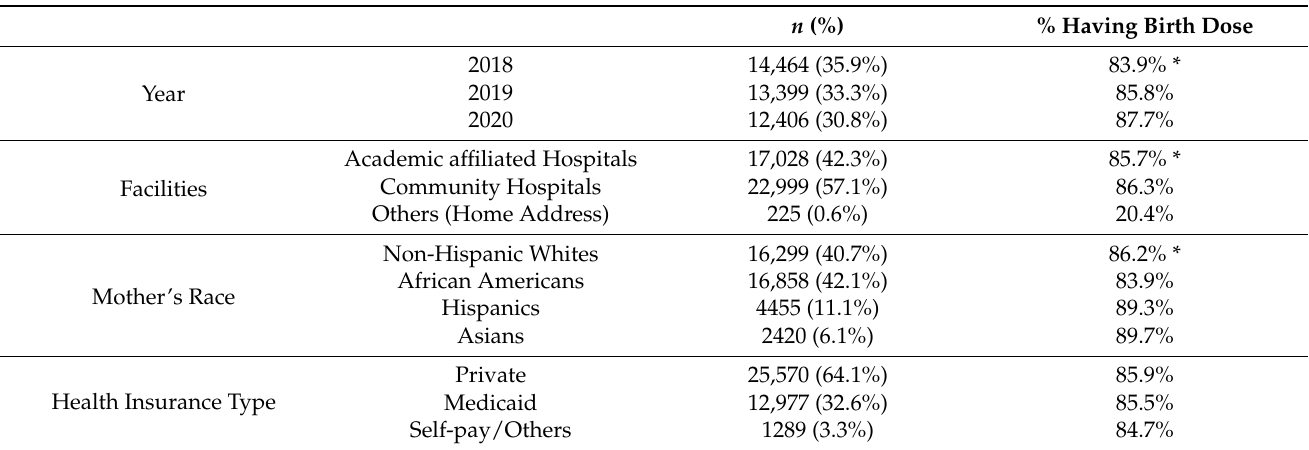
Table 2. Background characteristics and bivariate analyses of HepB birth dose, Washington metro- politan hospitals ( n = 40,269), 2018–2020.